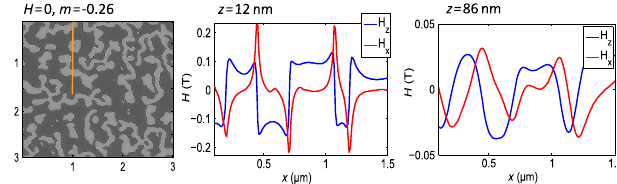
FIG. 13. Left: XMCD image of a magnetic electrode show- ing a magnetic configuration that corresponds to H (cid:2) 0 and M (cid:2) (cid:3) 0 : 26 M s of Fig. 3(c). The middle and right panels show and H ) along the XMCD image’s vertical the fringe fields ( H x z orange line at distances z ¼ 12 ; 86 nm from the surface of the magnetic electrode, respectively.